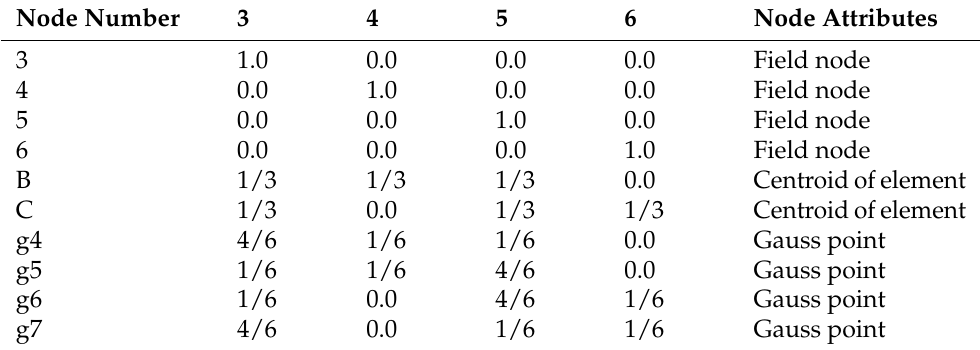
Table 2. The shape function entries at different points on the internal smoothing domain connected with the inner edges 3–5 in Figure